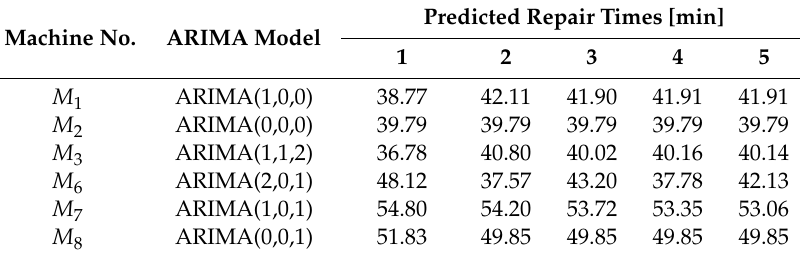
Table 4. Predicted machine repair